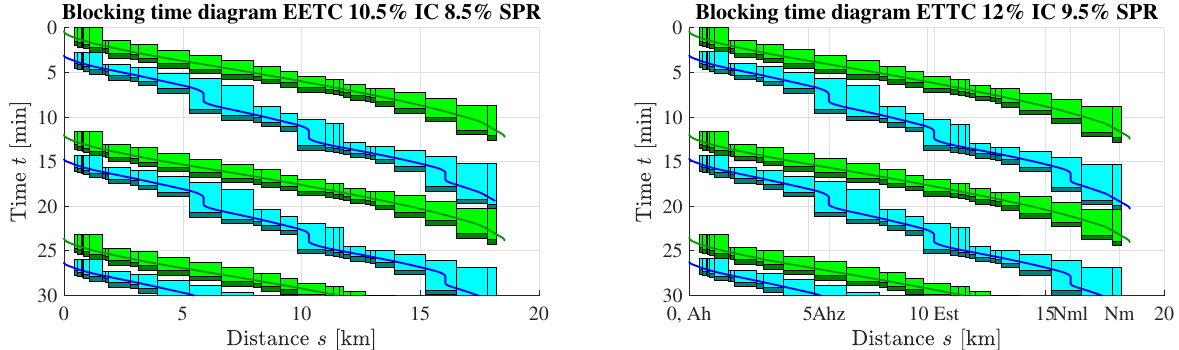
Figure 14: The left plot shows for the case Ah-Nm for the IC (green) and SPR (blue) compressed blocking time diagram for the EETC driving strategies with 10.5% running time supplements for the IC and 8.5% running time supplements for the SPR. The right plot indicates the IC (green) and SPR (blue) compressed blocking time diagram for the case Ah-Nm for the EETC driving strategies with 12% running time supplements for the IC and 9.5% running time supplements for the